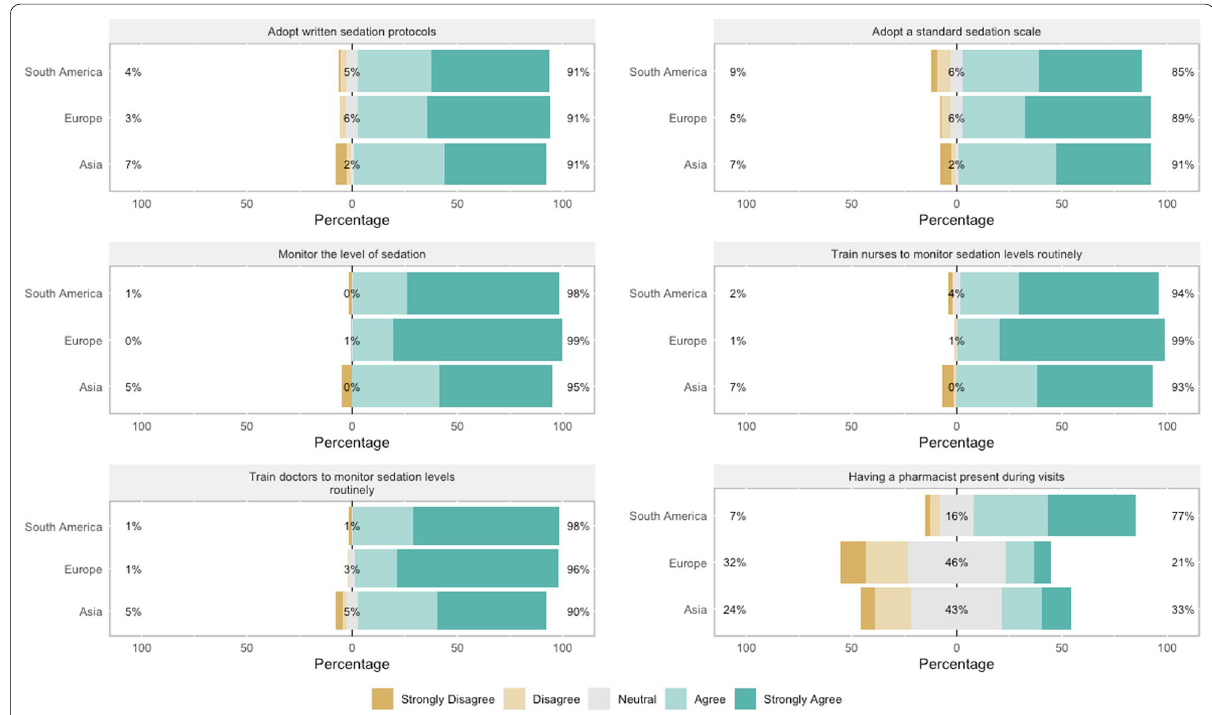
Fig. 3 Physicians’ opinions about strategies for improving ICU sedation practices stratified by